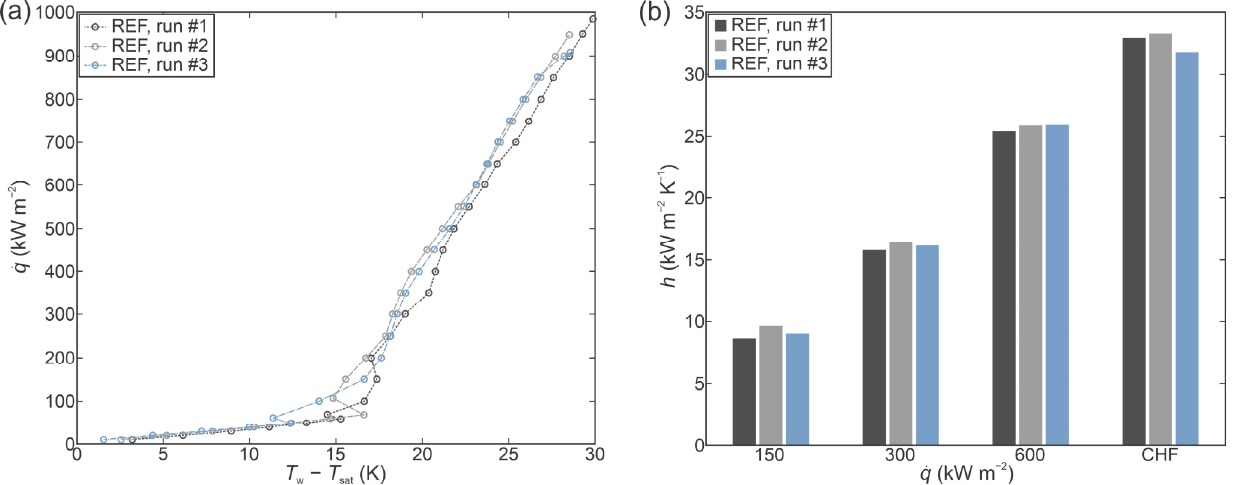
Figure 3. Boiling performance of the untreated reference sample (REF) evaluated through ( a ) boiling curves and ( b ) heat transfer coefficients at selected heat fluxes.